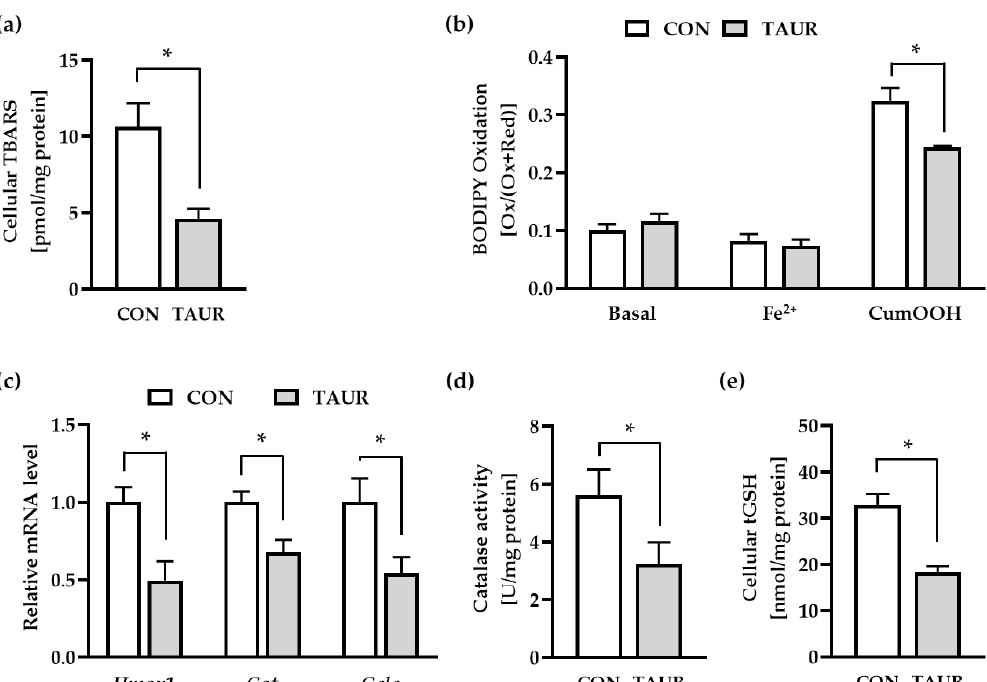
Figure 2. Taurine (TAUR) reduced markers for lipid peroxidation (LPO) and cellular redox homeostasis. ( a ) TAUR reduced the level of secondary LPO products measured as thiobarbituric acid reactive substances (TBARS). ( b ) To examine LPO under basal and stress conditions, myotubes were treated with the fluorescent dye C11 (undecanoic acid)-BODIPY 581 / 591, and then DPBS bu ff er was added in the absence or presence of 2 µ mol / L iron(II) sulfate (Fe 2 + ) and 80 µ mol / L cumene hydroperoxide (CumOOH). TAUR counteracted CumOOH-induced lipid peroxidation. BODIPY oxidation was determined by the ratio of oxidized to total BODIPY (oxidized + reduced) measured as fluorescence intensity. ( c ) The mRNA levels of heme oxygenase 1 (Hmox1), catalase (Cat) and glutamate-cysteine ligase, catalytic subunit (Gclc) were downregulated after 6 h of treatment with TAUR. ( d ) Catalase activity was significantly downregulated due to 24 h of incubation with TAUR compared to CON. ( e ) TAUR decreased the cellular content of total glutathione (tGSH = GSH + GSSG) under basal conditions. The data are shown as the means + SEM ( n ≥ 6). * Indicates significant di ff erences compared with CON; p < 0.05. Glutathione (GSH); glutathione disulfide (GSSG).